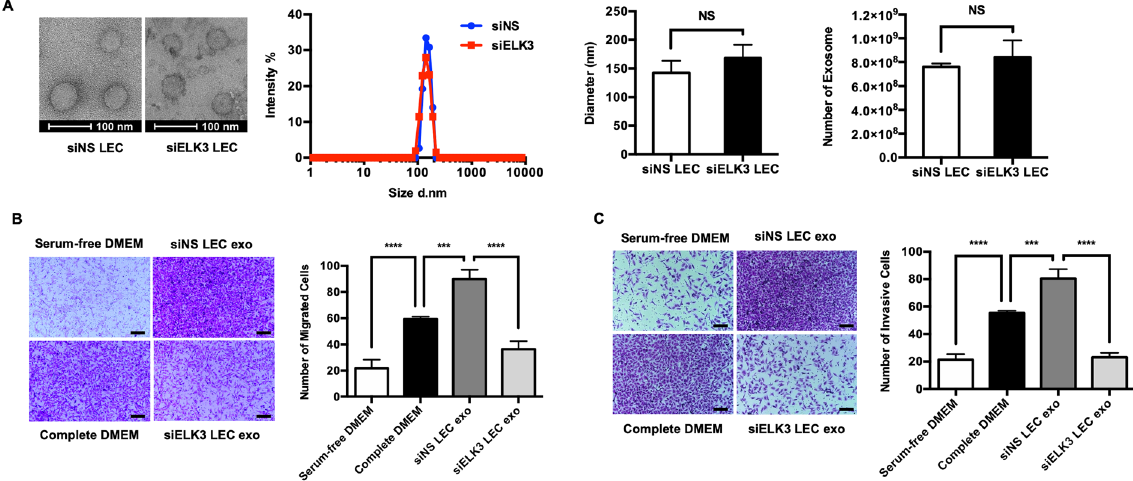
Figure 4. Suppression of ELK3 in LECs diminishes the ability of LEC-derived exosomes to promote cancer cell migration and invasion in vitro . ( A ) Exosomes purified from siNS- or siELK3-transfected LECs were examined via electron microscopy (Left). Scale bar represents 100 nm. The size distribution of the exosomes was measured by DLS (Middle). The total number of exosomes derived from siNS- or siELK3-transfected LECs was analyzed by detecting the expression level of exosomal marker, CD69 (Right). The effect of exosomes purified from siNS- or siELK3-transfected LECs on the migration ( B ) or invasion ( C ) of MDA-MB-231 cells was measured by a transwell assay. Serum-free DMEM and complete DMEM were added to MBA-MB-231 cells as ( − ) and ( + ) controls for the migration and invasion assay. Scale bar represents 100 μ m. Error bars represent the standard error from three independent experiments, and each experiment was performed using triplicate samples. * P < 0.05, ** P < 0.01 *** P < 0.001 and **** P < 0.0001 (Student’s